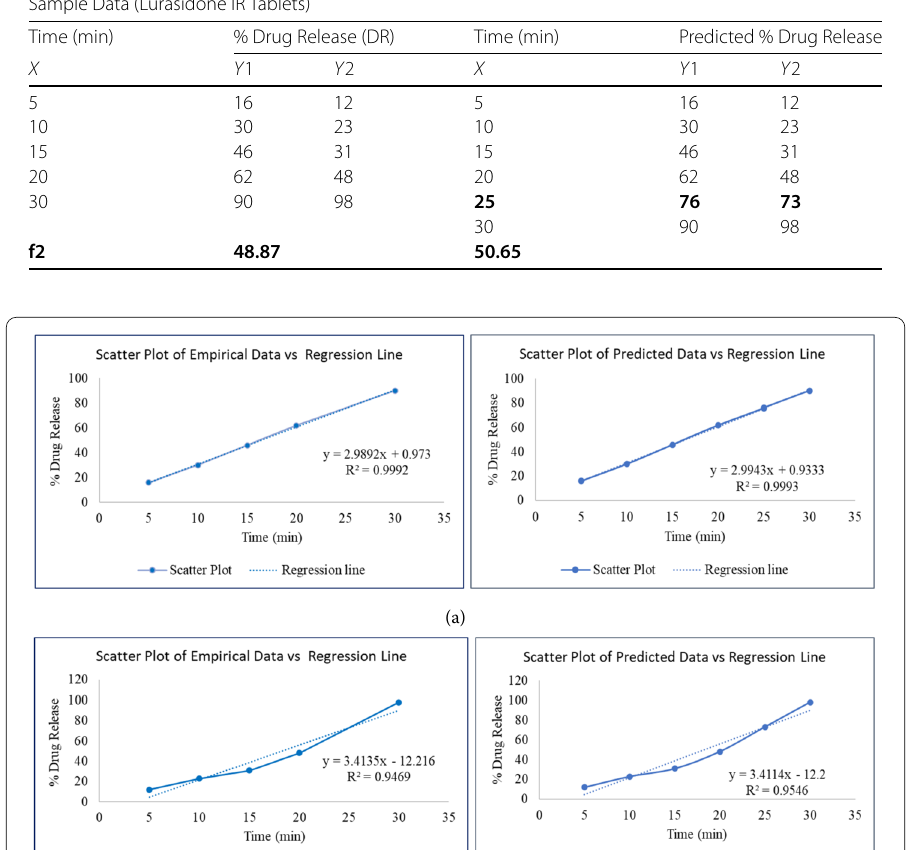
Table 5 Comparison of two drug release profiles of Lurasidone IR Tablets Sample Data (Lurasidone IR